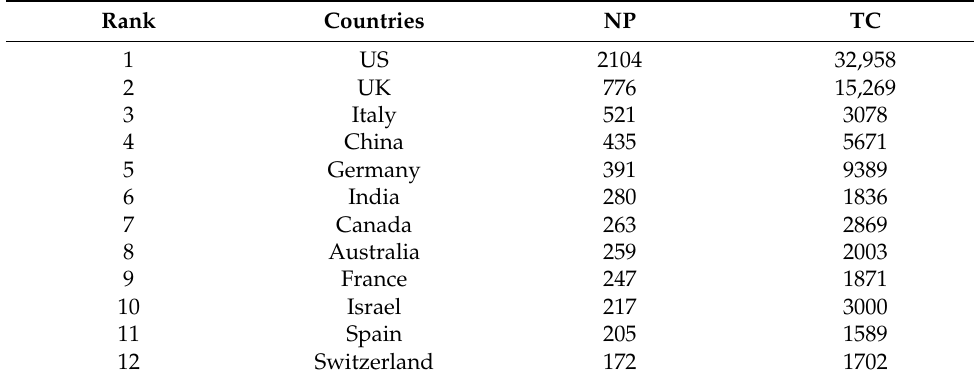
Table 3. The most prolific countries in COVID-19 vaccine research.